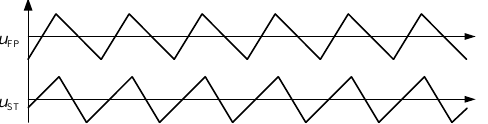
Figure 5. Primary winding voltages of the injection transformers when input voltage of the rectifier is harmonic-free. From [12–14], almost all the harmonic reduction methods generate multistep wave- forms which are equivalent to the ideal injection waveform (as shown in Figure 5) to suppress harmonics. That is because the cost and difficulty of generating multistep waves are much lower than these of the triangular waves. Besides, the harmonic reduction effects of the multistep wave and the triangular wave are similar. From Figure 5, there are three combinations of currents i x1 and i x2 , which are 1 (cid:13) i x1 > 0, i x2 > 0, 2 (cid:13) i x1 > 0, i x2 < 0, 3 (cid:13) i x1 < 0, i x2 > 0. On the basis of the on–off state of VD 1 , VD 2 , and the currents i x1 and i x2 , the harmonic suppression circuit has seven modes, described as Figure 6.